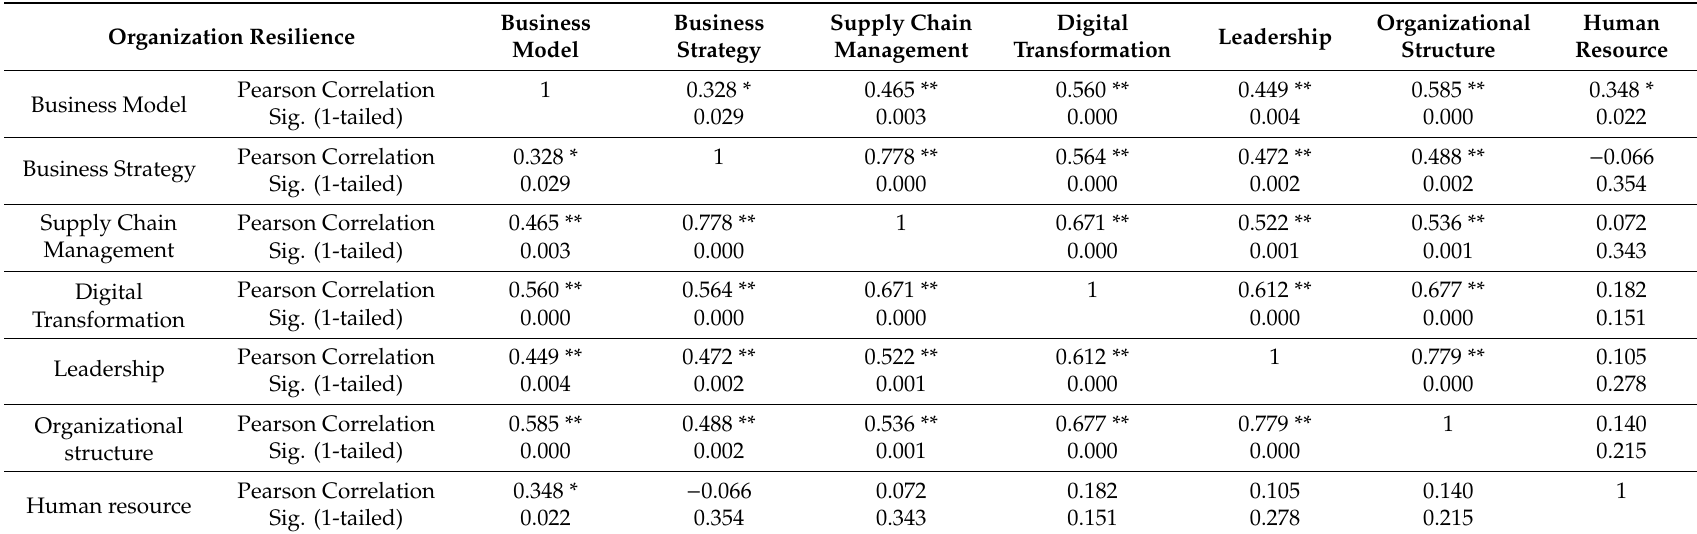
Table A1. Pearson’s